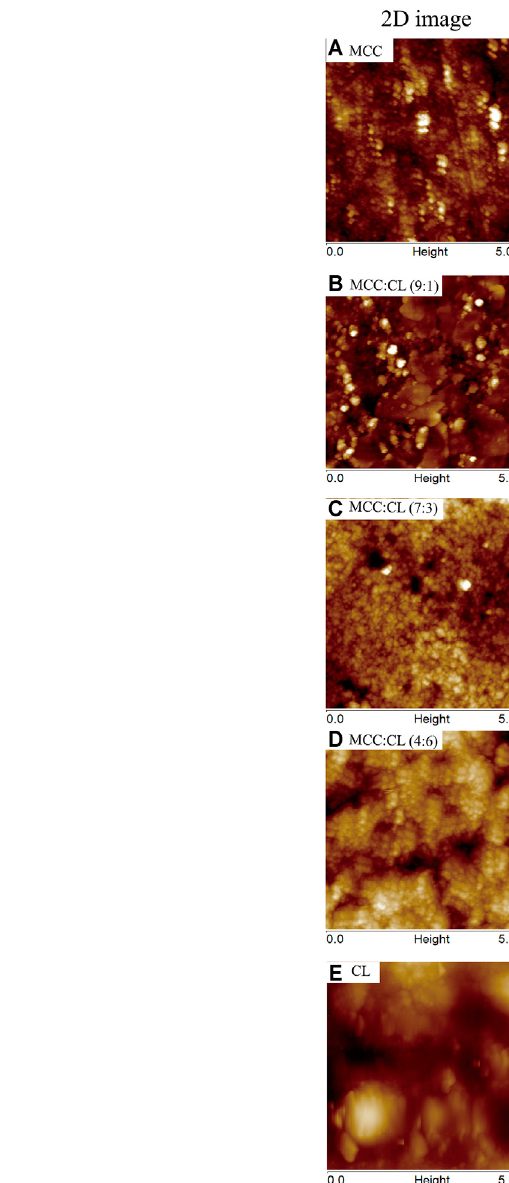
Frontiers in Bioengineering and Biotechnology |